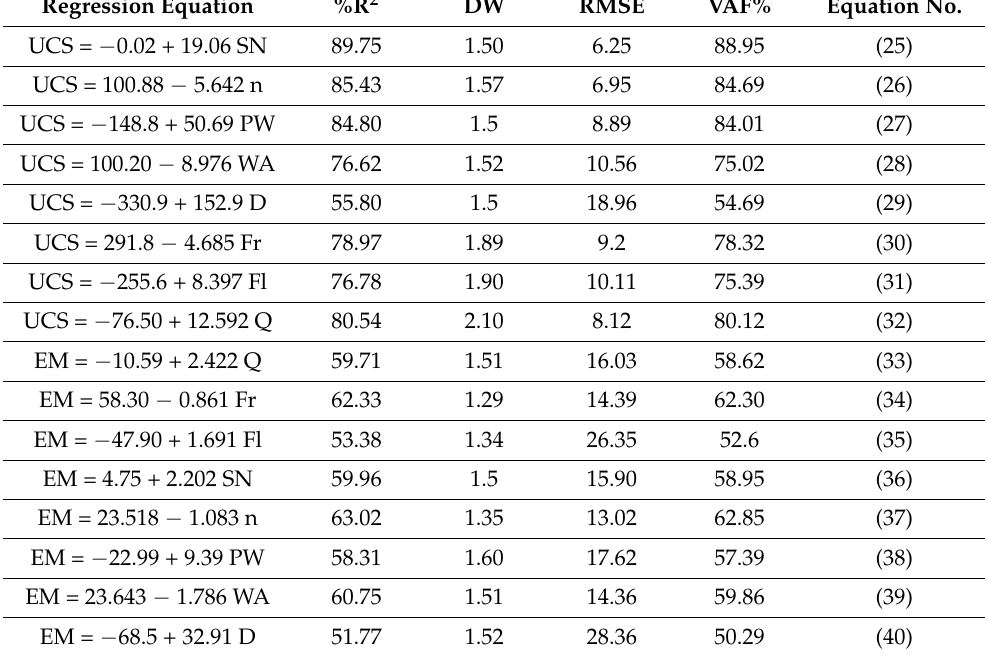
Table 3. Simple regression results.